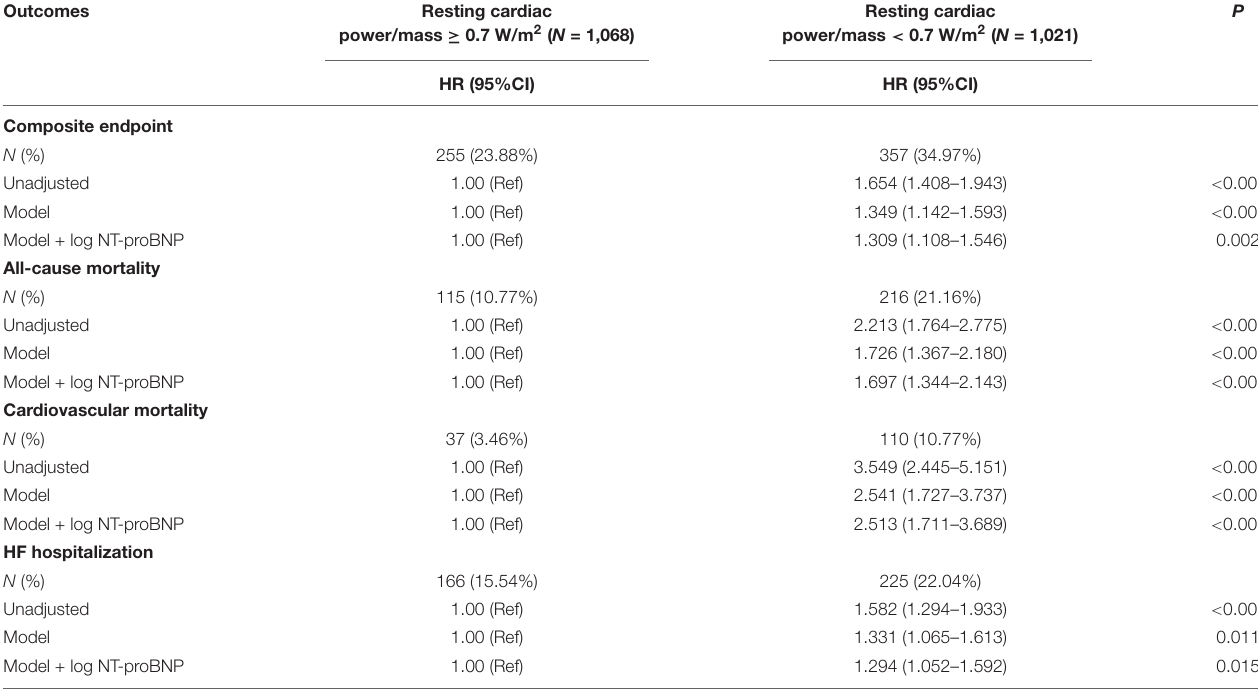
TABLE 2 | Outcomes of HFpEF patients by resting cardiac power/mass